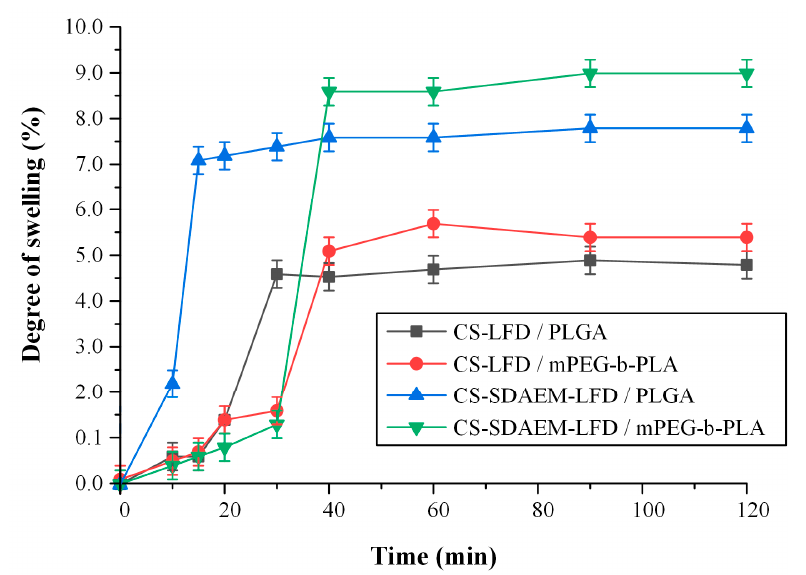
Figure 13. Degree of swelling vs. time of mPEG-b-PLA and PLGA thin-films with LFD-loaded NPs.